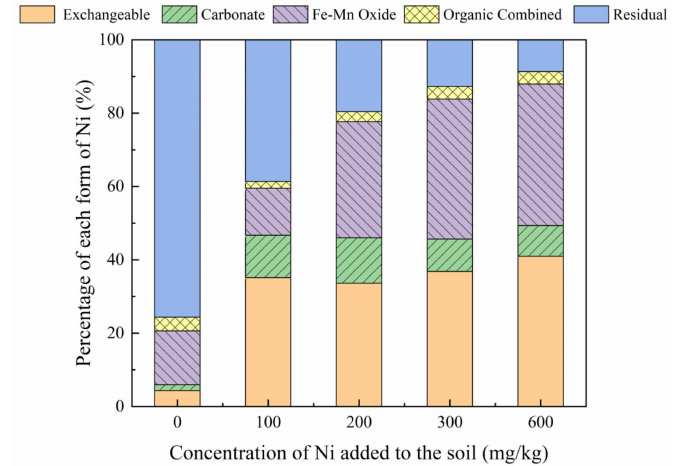
Figure 1. Distribution of different Ni forms after the addition of exogenous Ni (0, 100, 200, 300, 600 mg/kg) to the mine